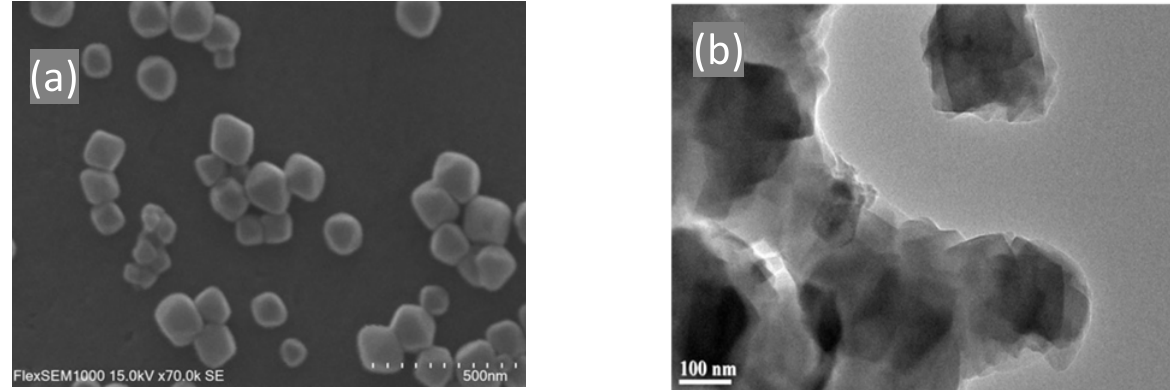
Figure 6. SEM images of ( a ) UiO ‐ 66 and TEM images of ( b ) UiO ‐ 66.